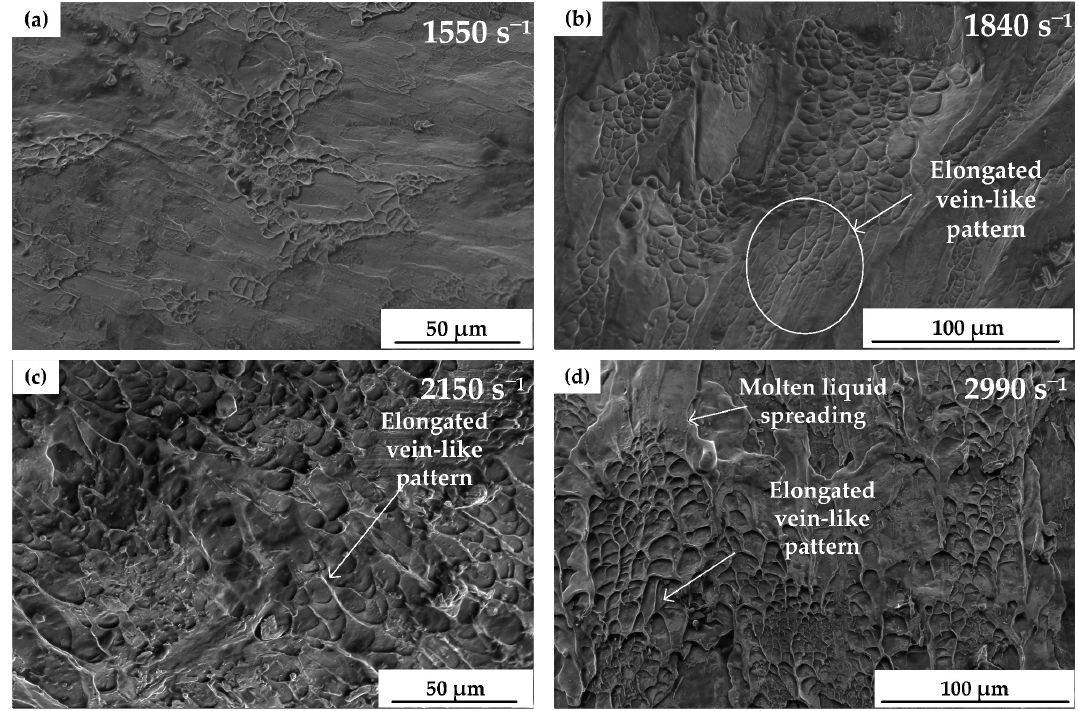
Figure 6. Vein-like pattern in the fracture surface of dynamic compressive tests. ( a ) 1550 s − 1 , ( b ) 1840 s − 1 , ( c ) 2150 s − 1 , and ( d ) 2990 s − 1 .